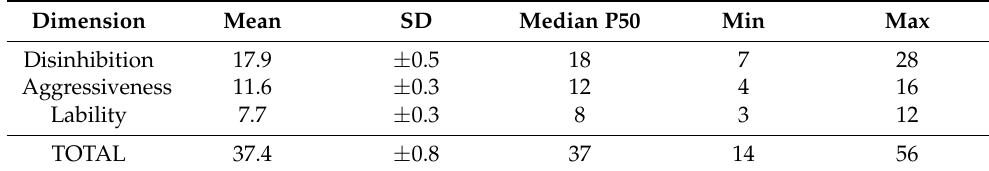
Table 2. Mean, standard deviation and median of the total level of psychomotor agitation and its